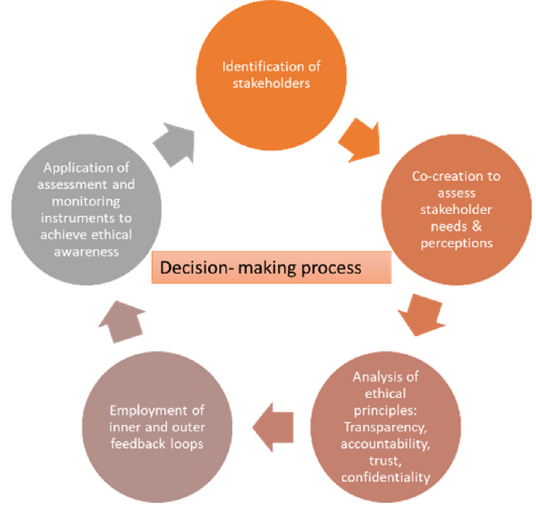
Figure 1. An Ethical compliant Decision-Making Framework for IoT.